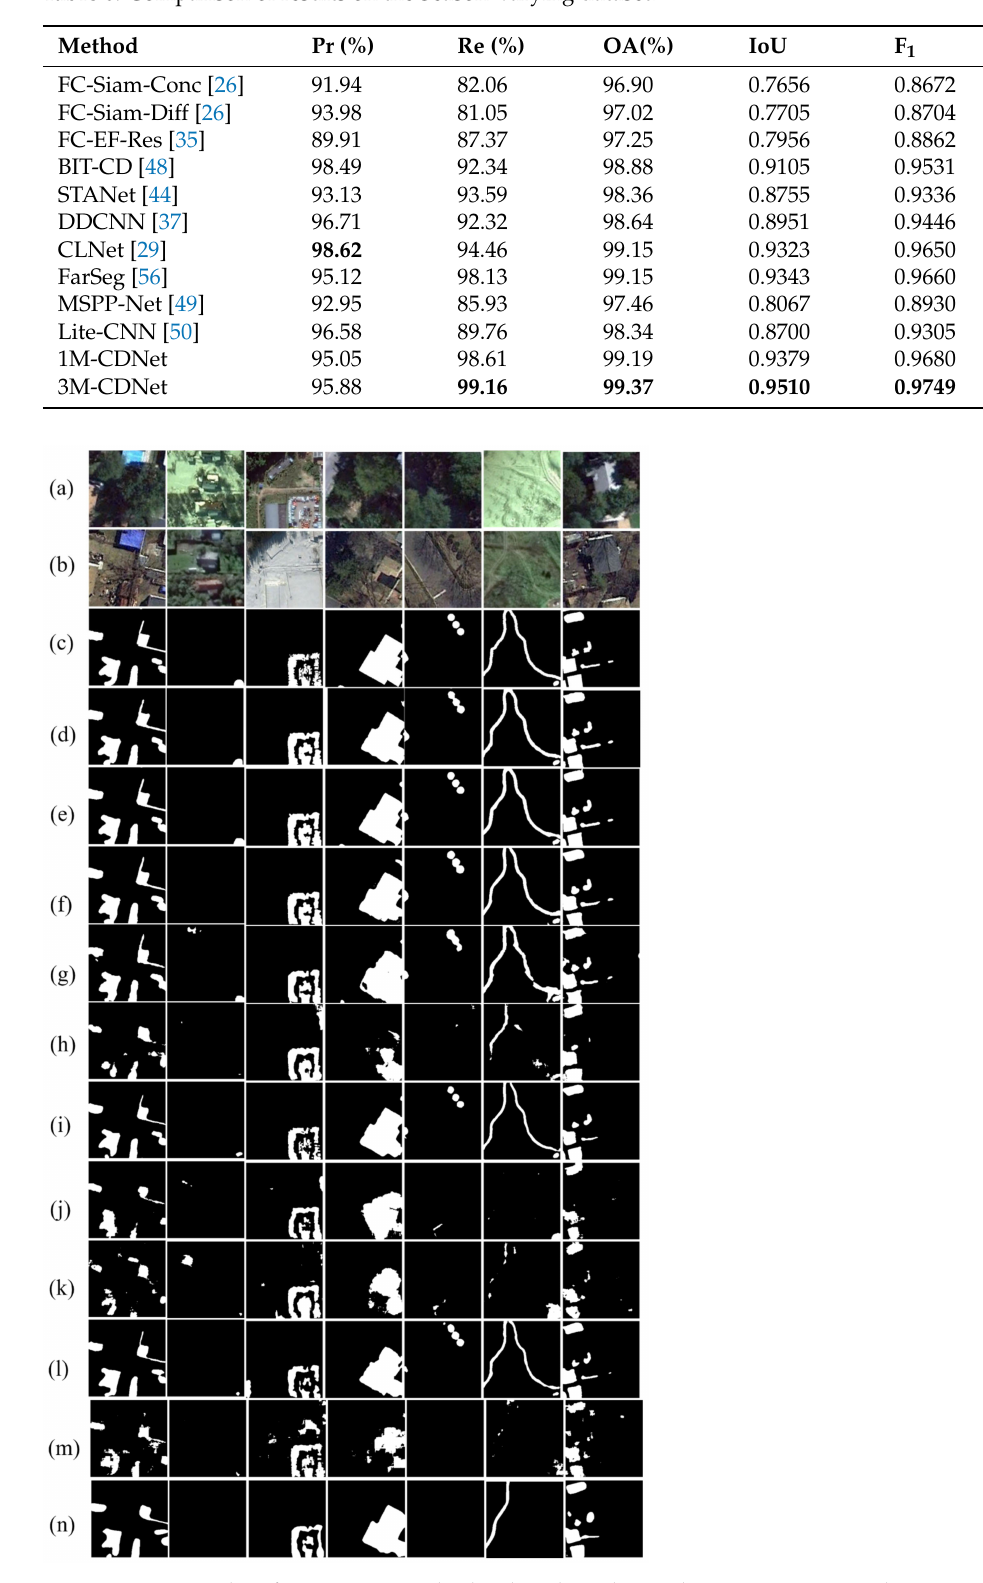
Figure 5. CD results of 3M-CDNet and other benchmarks on the Season-Varying dataset. Zoom in for an improved view. ( a ) Image T1. ( b ) Image T2. ( c ) Reference change map. ( d )